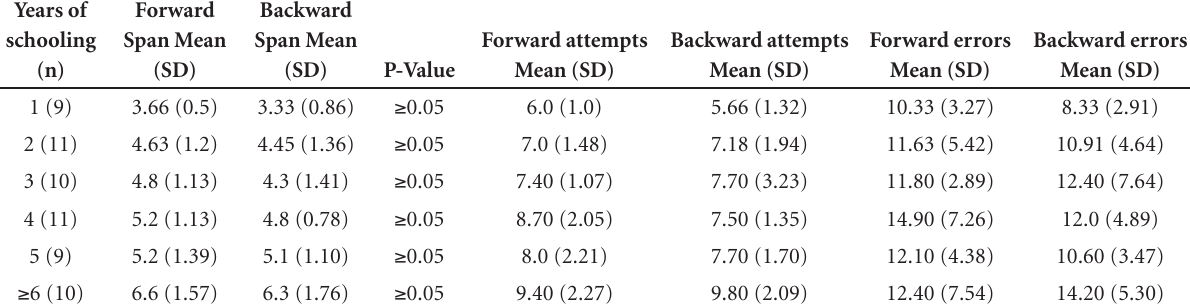
Table 3. Performance by years of schooling. Years